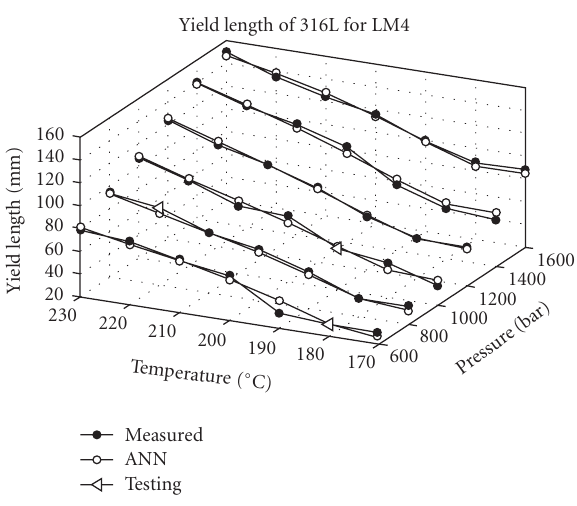
Figure 20: Comparison of the measured and predicted yield length for